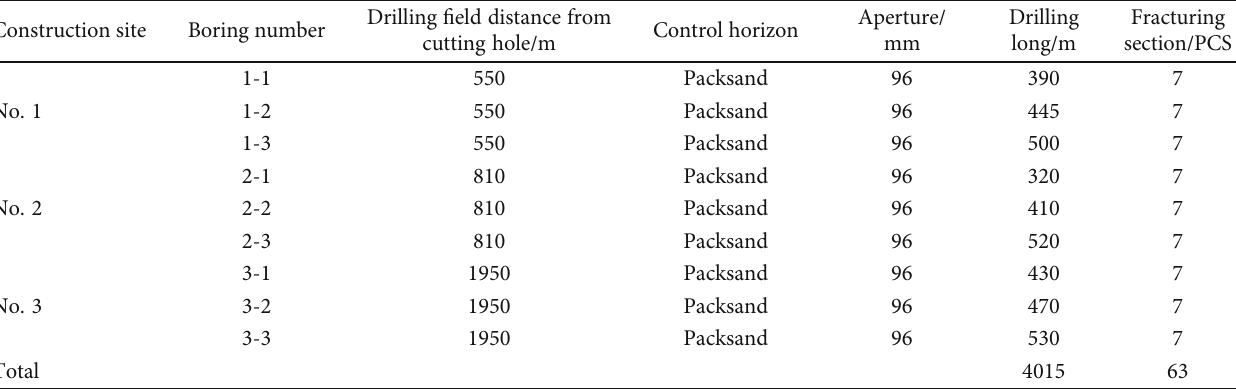
Figure 2: Design plan of fracturing drilling. Table 1: Drilling construction parameters.